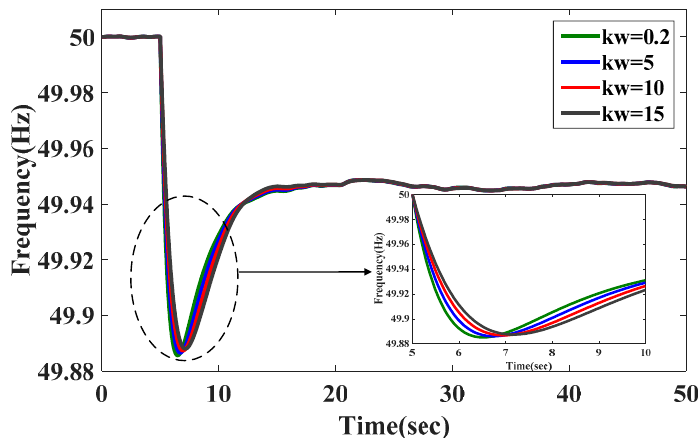
Figure 13. The impact of parameter k w on frequency dynamic response.